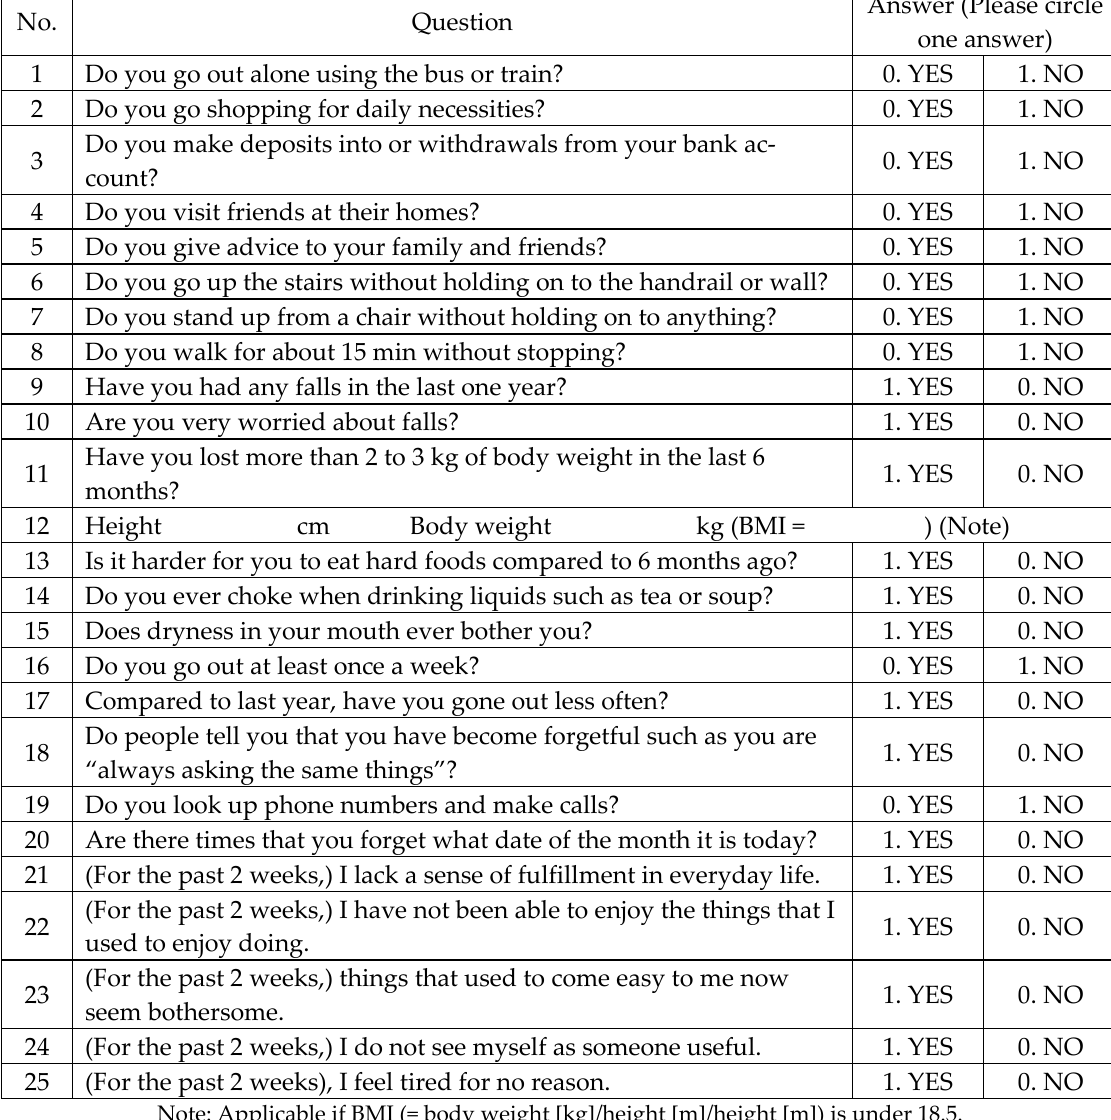
Figure 1. Basic health checklist (The Ministry of Health, Labour and Welfare of Japan Home Page. Available online: https://www.mhlw.go.jp/topics/2009/05/dl/tp0501-1c_0001.pdf (Japanese, accessed on 18 October 2021).